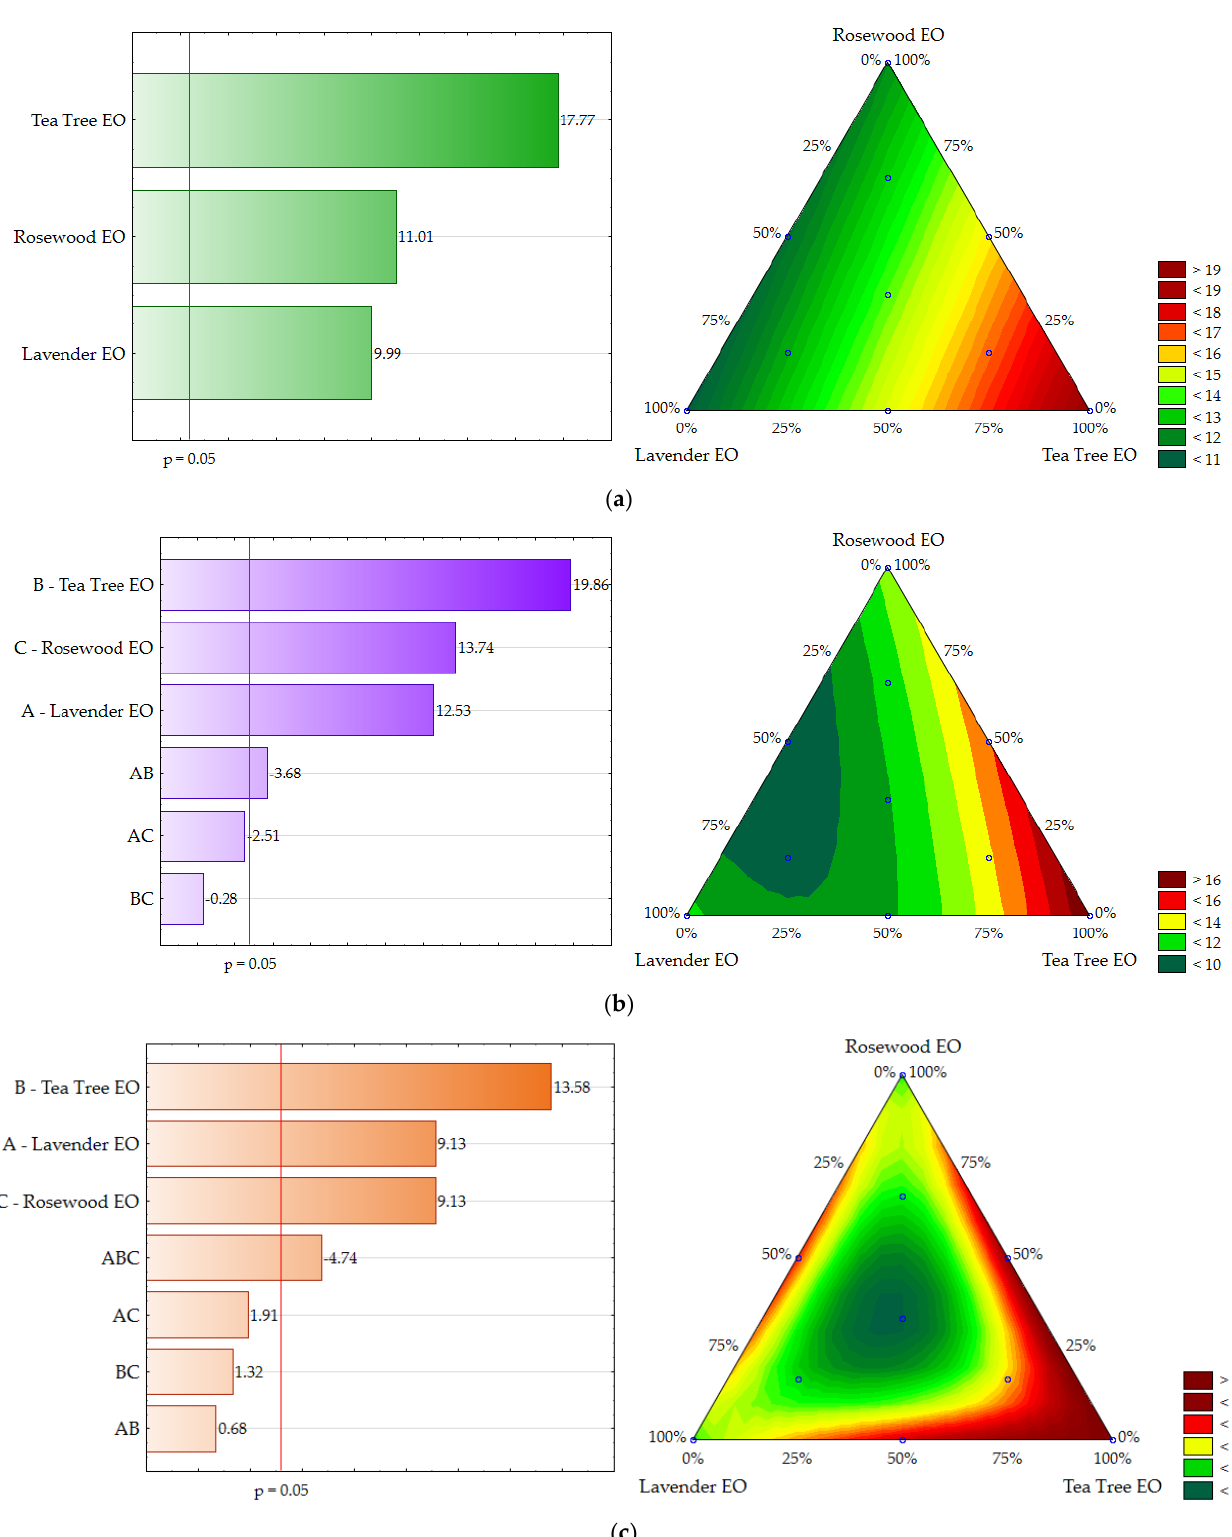
Figure 1. Optimization of antimicrobial activity by means of mixture design, presented as Pareto charts and contour plots for a: ( a ) Linear model for E. coli PCM 2057, ( b ) quadratic model for L. monocytogenes PCM 2191, ( c ) special cubic model for R. mucilaginosa EPSC001.